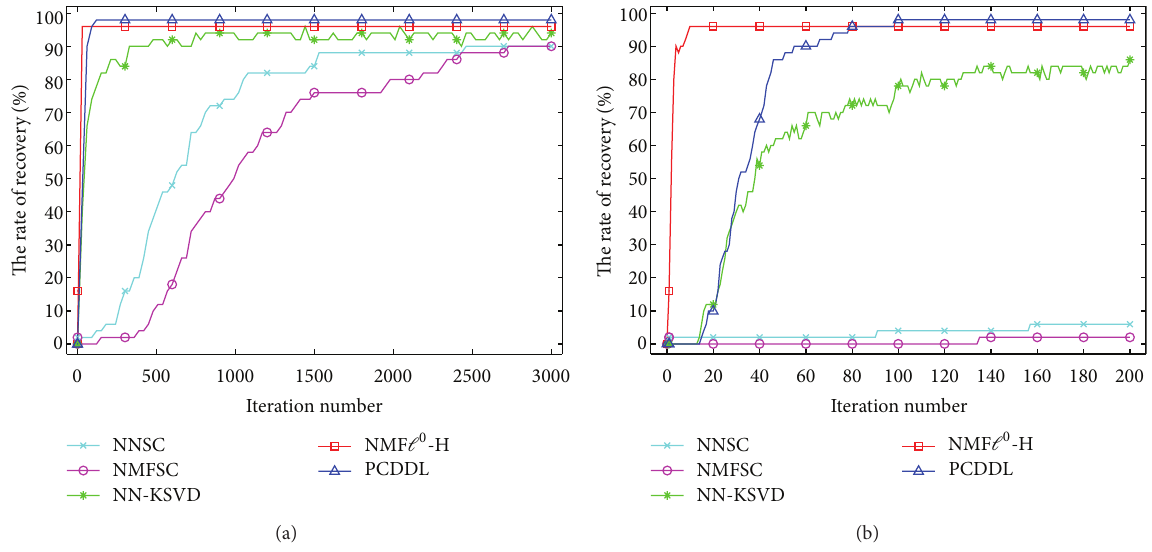
Figure 1: Evolution of the rate of atom recovery versus the iteration number of five algorithms. (a) It shows 3000 iterations. (b) It is a close-up view of the former 200 iterations for (a).